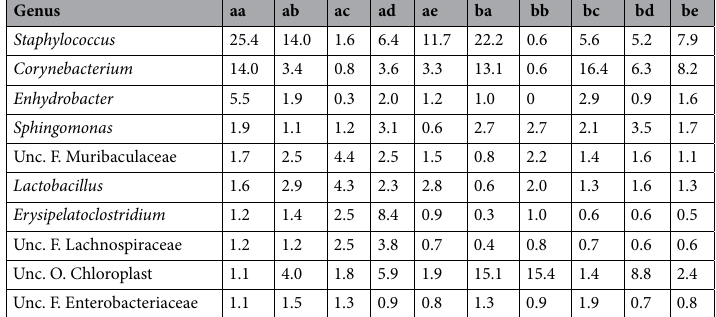
Table 1. The relative abundance (%) of some dominant groups in each sample.